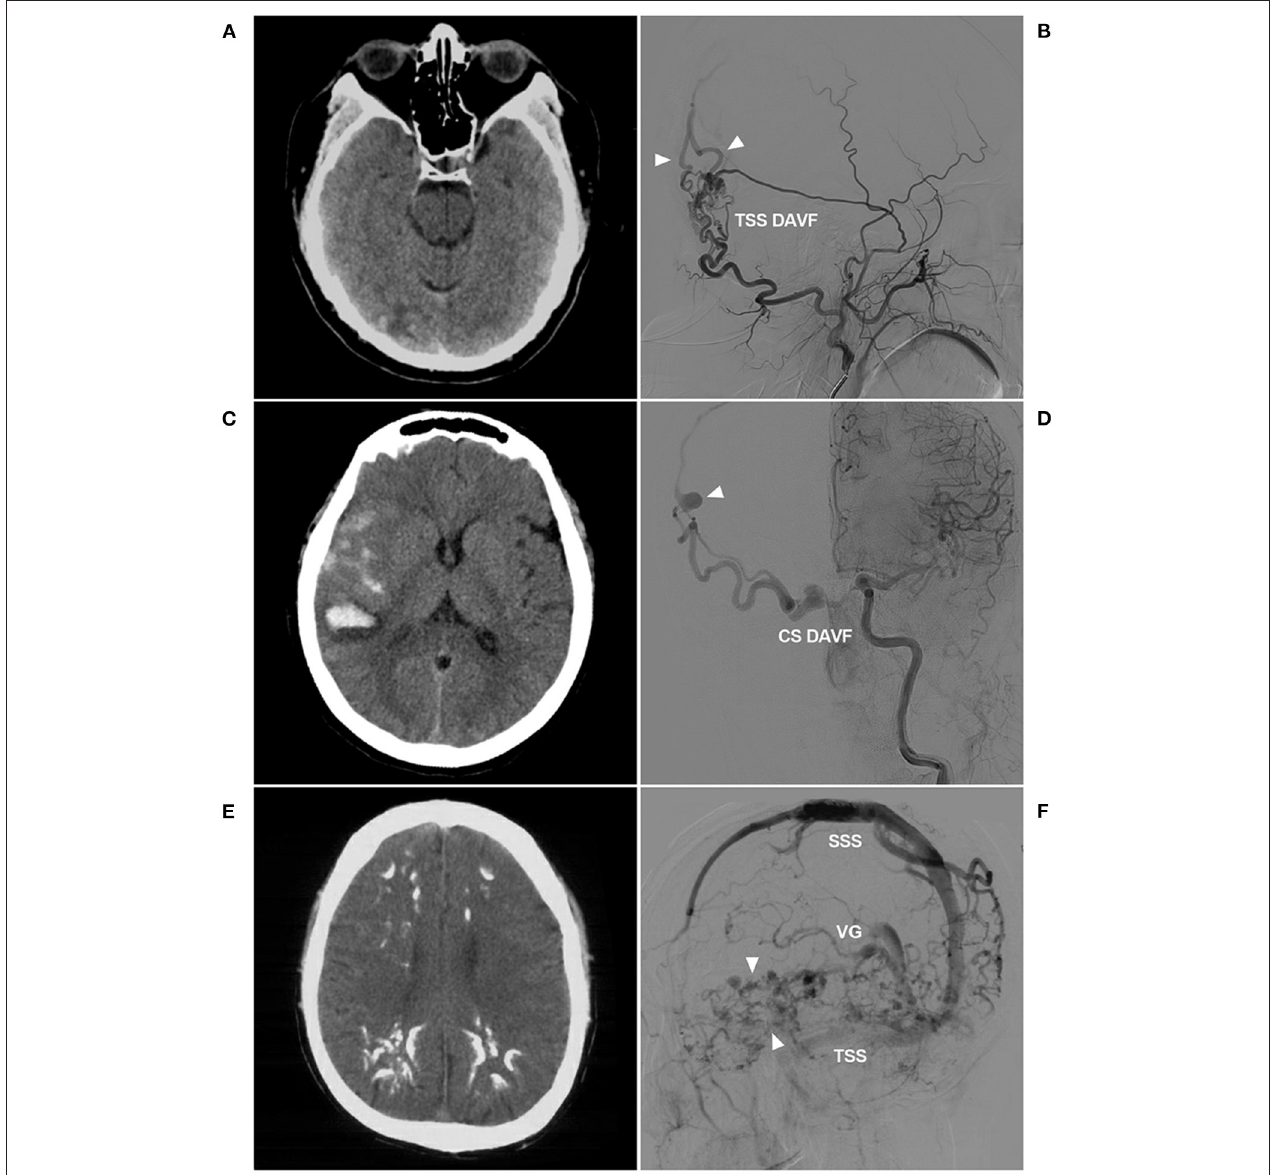
FIGURE 1 | Venous drainage patterns of DAVFs. (A,B) Unruptured DAVF with images from the same patient. CT (A) showed a mix of high and low densities in the right occipital lobe. DSA (B) showed a TSS DAVF draining to multiple cortical veins (triangles), and the veins throughout the entire brain were normal and not dilated. (C,D) Hemorrhagic DAVF with images from the same patient. CT (C) showed subarachnoid hemorrhage and hematoma in the Sylvian fissure region. DSA (D) showed a CS DAVF with cortical vein drainage and a ruptured venous aneurysm (triangle). (E,F) Extensive pseudophlebitic DAVF with images from the same patient. CT (E) showed multiple calcifications in the white matter around the ventricle. DSA (F) showed an extensive pseudophlebitic pattern involving superficial and deep veins (triangles). CS, cavernous sinus; CT, computed tomography; DAVF, dural arteriovenous fistula; DSA, digital subtraction angiography; SSS, superior sagittal sinus; TSS, transverse-sigmoid sinus; VG, vein of